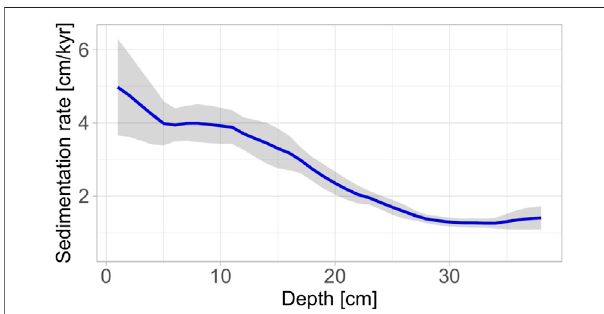
FIGURE 4 | Derived sediment accumulation rates using the BACON model and all 14 C ages (averages of the small-volume bulk and the small-n samples). The rate decreases from the upper core part towards the bottom of the core. The con fi dence intervals are ± one standard deviation of all realizations from BACON.